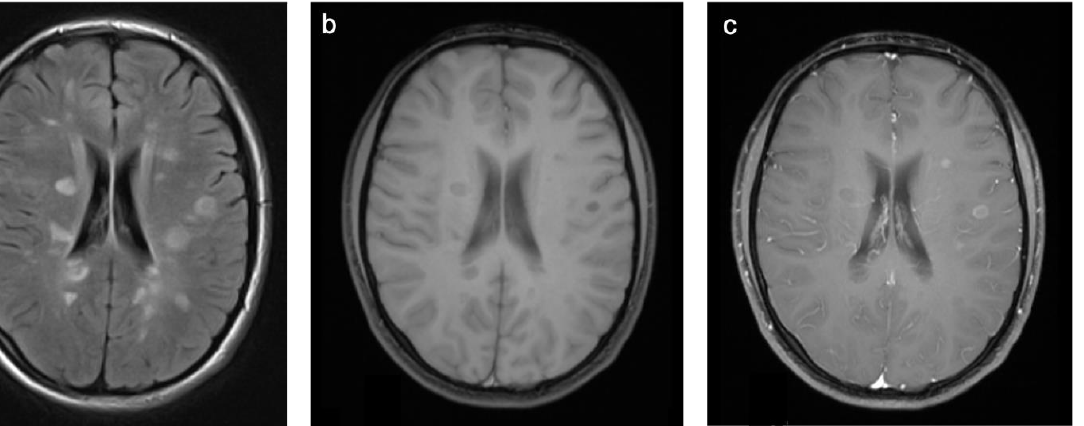
Figure 3. Representative case “Autoimmune disorders”: MS. FLAIR ( a ), T1W pre- and post-contrast ( b , c ) sequences. Fifteen-year-old girl diagnosed with MS. MRI shows characteristic ovoid/round lesions with asymmetric distribution abutting the lateral ventricles (periventricular) and touching the cortex (juxtacortical) [19] ( a ). Contrast-enhancing lesions in T1W post-contrast sequences are considered markers of blood – brain barrier breakdown ( c ).